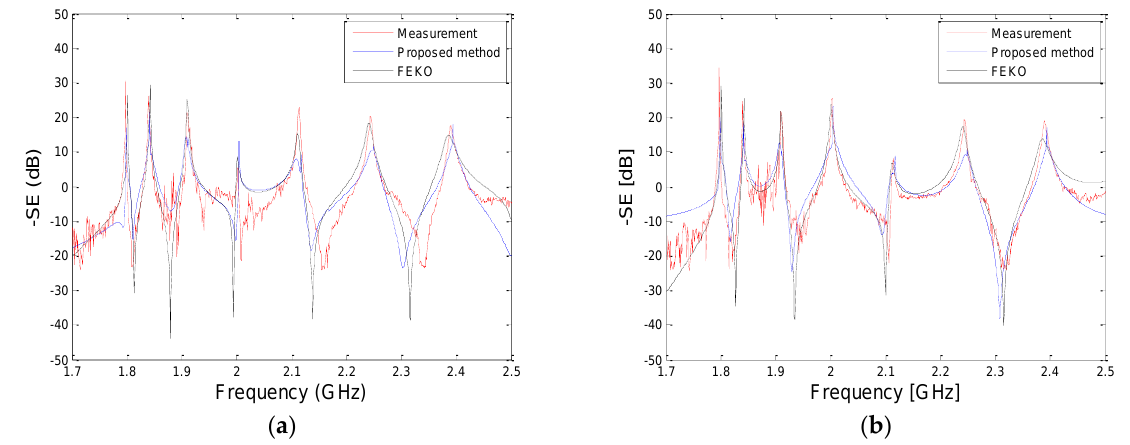
Figure 7. Comparison of the E − field Ey between the measurement and the proposed method: ( a ) P1; and ( b ) P2.